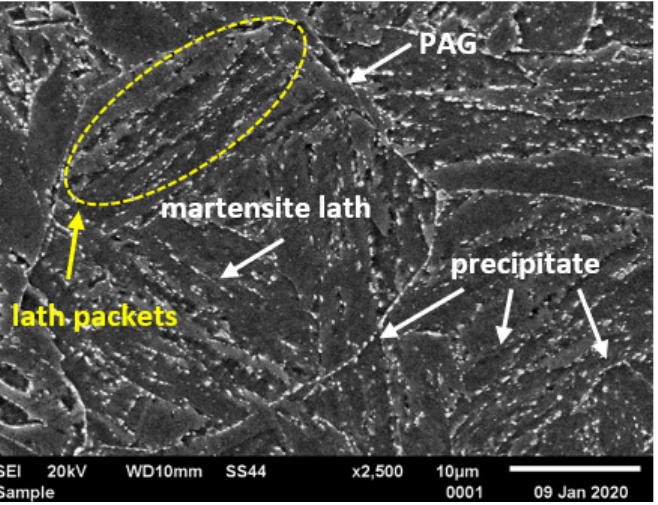
Figure 2. Microstructure of T115 steel in initial condition by scanning electron microscopy (SEM). In turn, the MX particles (niobium and/or vanadium-rich precipitates) can be observed within the martensite laths, and part of them is precipitated at the dislocations. In the matrix, these precipitates are distributed inhomogeneously. Unlike M 23 C 6 carbides, MX precipitates in 9%Cr steels are characterised by low coarsening rate. High thermal stability of these precipitates and coherent (semi-coherent) interfaces with the matrix cause that, despite their low volume fraction (approximately 0.020–0.025), these precipitates develop a strong precipitation hardening of steel and are an effective barrier to the free dislocation movement by the pinning effect